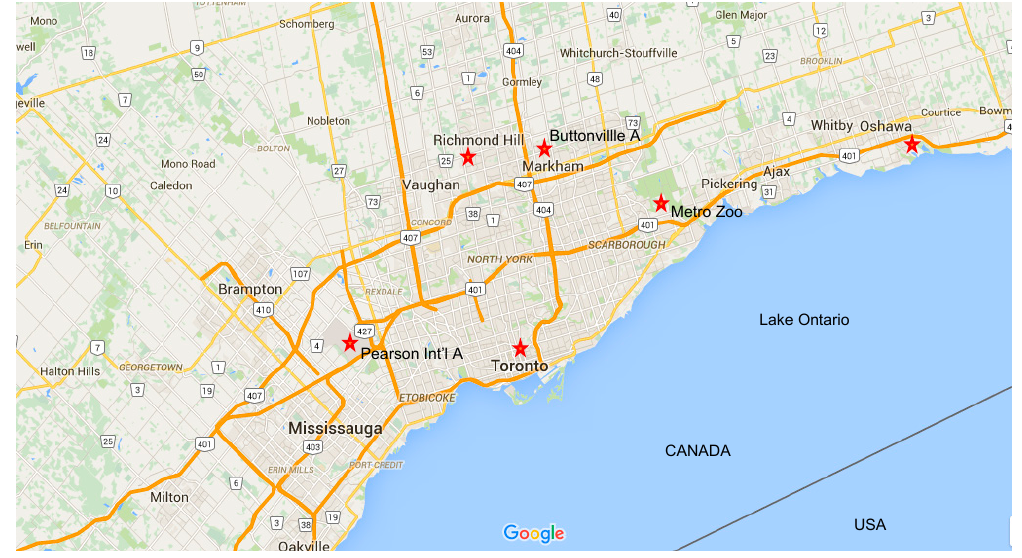
Figure 1. Map of the Toronto area showing location of the Toronto Zoo (formerly the Metro Zoo) and nearby weather stations.